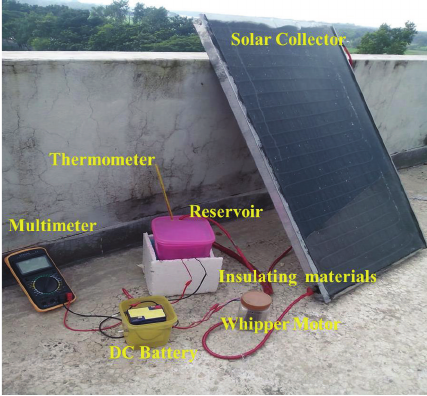
Figure 2: An instrumental setup of solar water heating system.